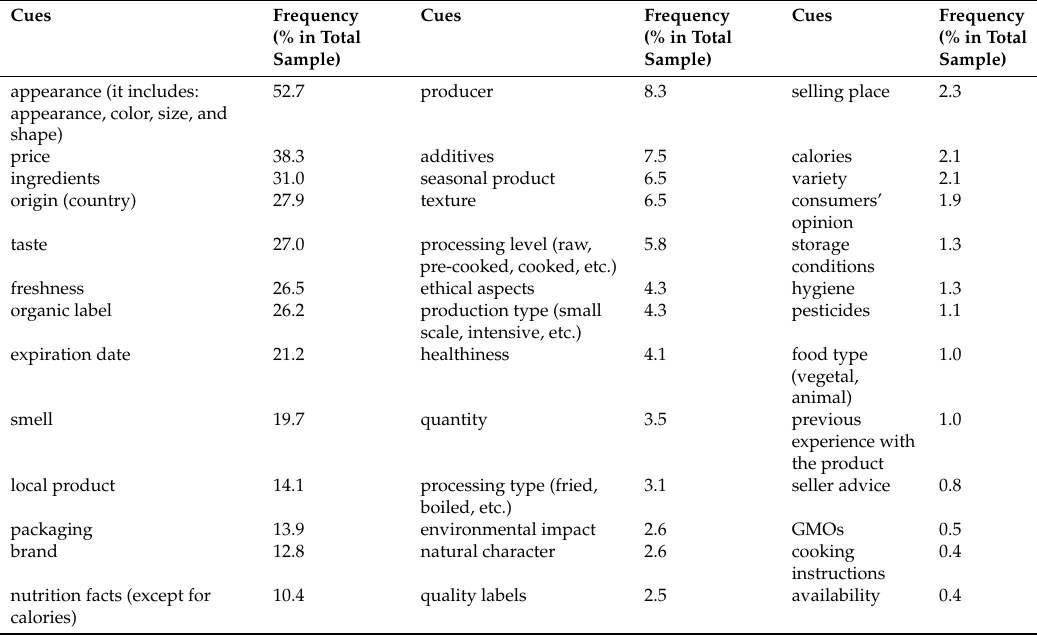
Table 3. Percentage of tested consumers who declared they use often a specific cue for the evaluation of food quality (unaided